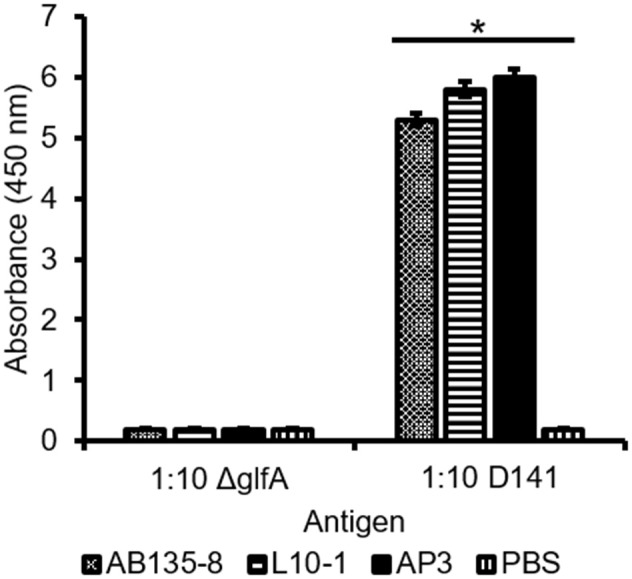
Detection of A. fumigatus D141 GM and ΔglfA supernatant by ELISA. Culture supernatants from A. fumigatus ΔglfA and wild-type D141 strains were coated (1:10) onto a microtiter plate. GM was detected using 400 ng/ml purified mAb AP3 or 400 ng/ml of the IgMs L10-1 and AB135-8, which recognize distinct Galf-dependent antigens, followed by isotype-specific antibodies labeled with HRP. Data are means ± SD (n = 3). An asterisk denotes a statistically significant difference in antigen binding between the D141 and ΔglfA strain (p < 0.005).